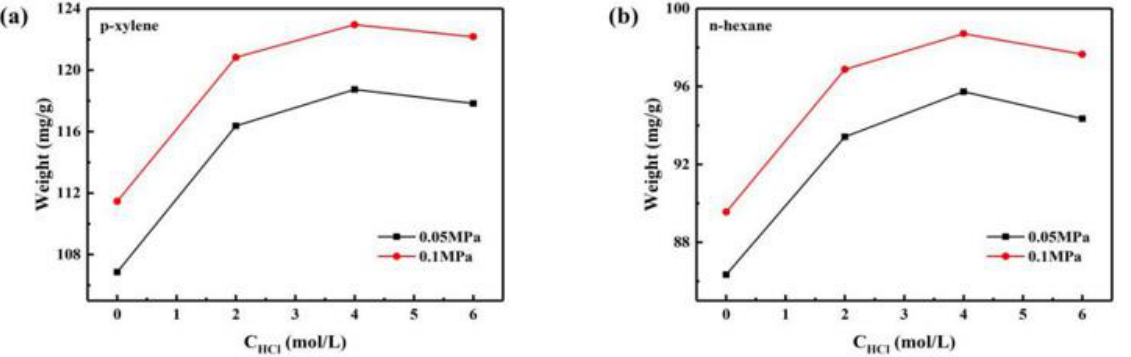
Figure 5. Variation in the adsorption capacities for ( a ) p-xylene and ( b ) n-hexane of samples after HCl treatment.